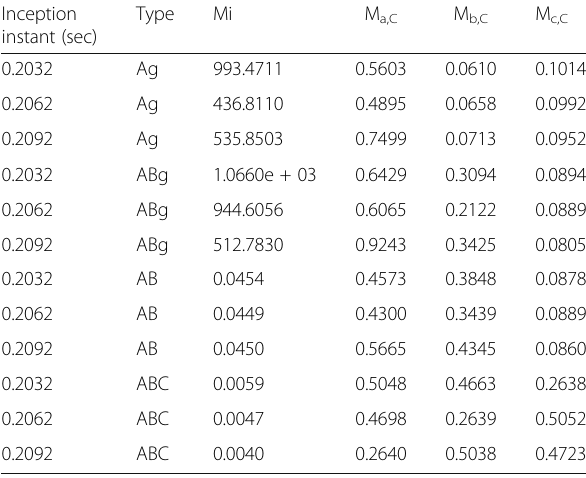
Table 2 Results of various fault inception